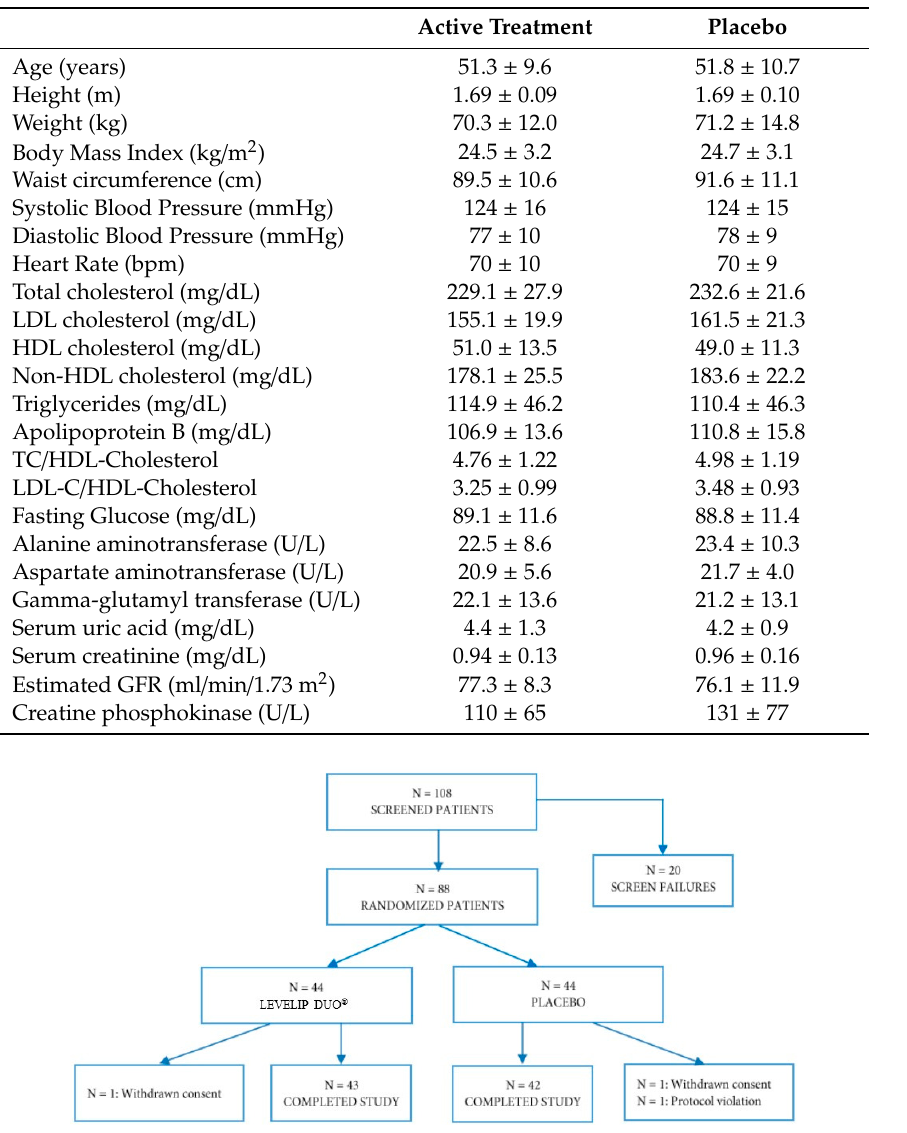
Figure 3. Plasma LDL-Cholesterol level percentage change from the baseline to 4 and 8 weeks in subjects treated with the tested combined nutraceutical or placebo. The LDL-C levels decreased from visit to visit in the combined nutraceutical group, and, on the contrary, increased in the placebo group. The mean change at week 8 was − 32.5 ± 30.2 mg/dL ( − 19.8%) in the combined nutraceutical group and 2.5 ± 19.4 mg/dL (2.3%) in the placebo group. The ANCOVA model results for the estimated change from baseline at week 8 in LDL-C levels, adjusting for the